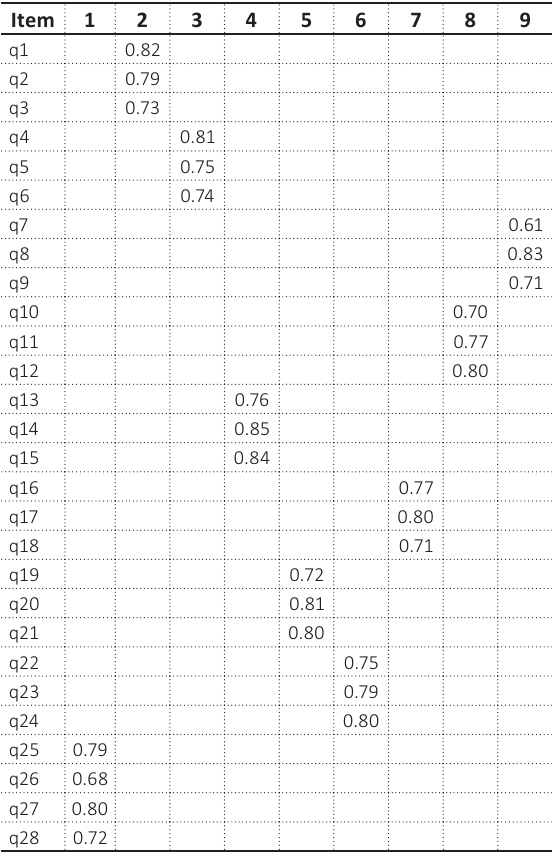
Table 4. Goodness-of-fit indices for first- and